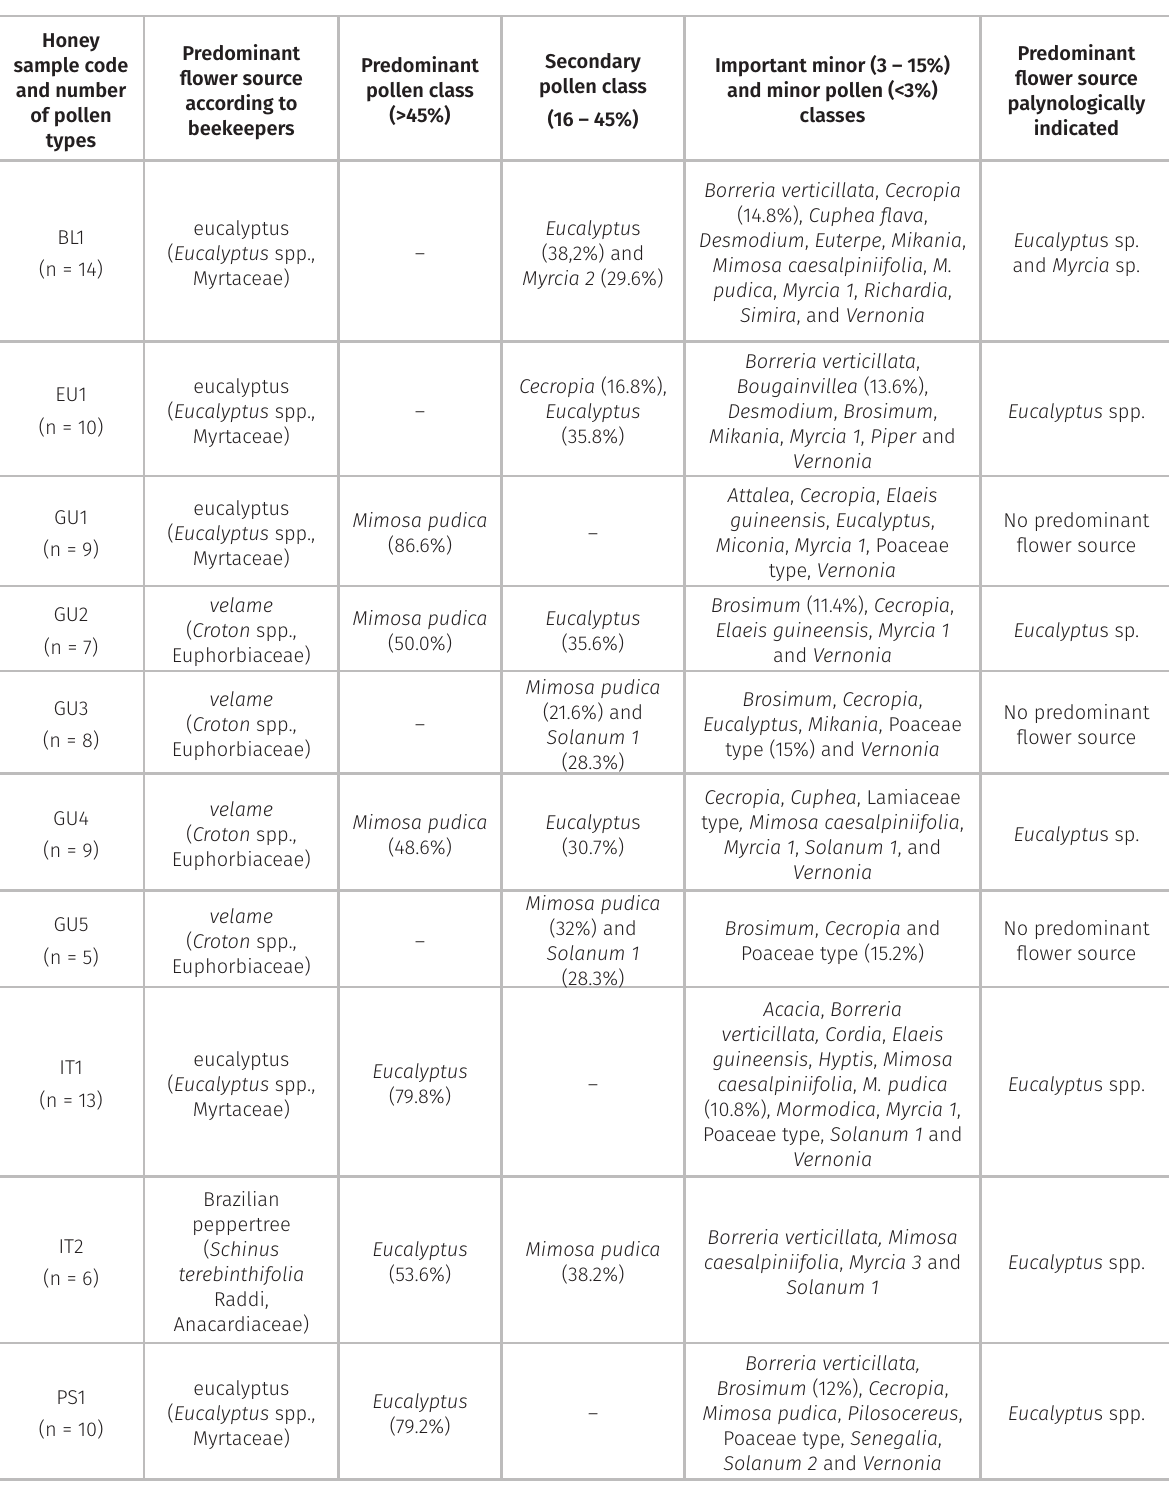
Table II. Pollen spectrum recognized in honey samples of Apis mellifera L. from the municipalities along the Discovery Coast (Bahia, NE Brazil): Belmonte (BL), Eunápolis (EU), Guaratinga (GU), Itabela (IT) and Porto Seguro (PS). Frequency classes according to Louveaux et al.